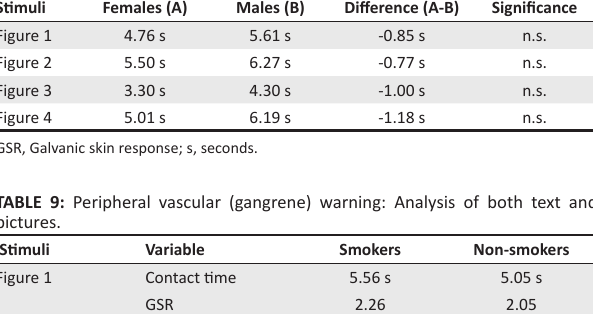
TABLE 8: Contact time results comparing genders: Text and pictures. Stimuli Females (A) Difference (A-B) Significance